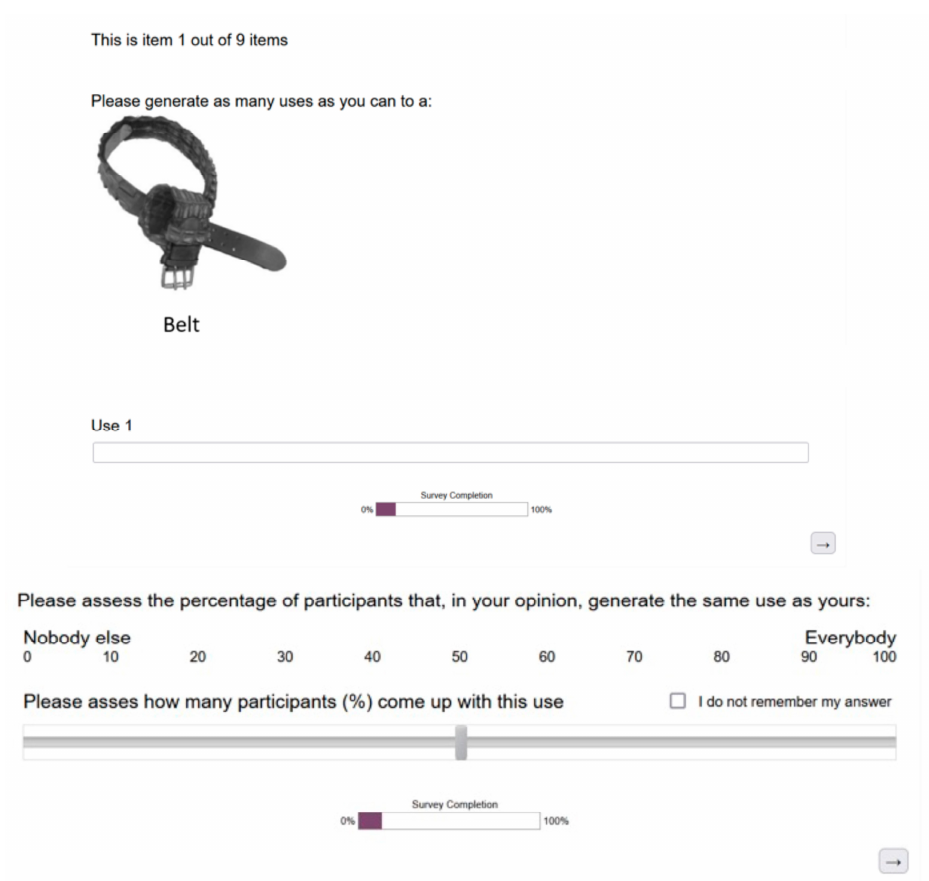
Figure 1 . An example of a trial in the AUT used in Experiment 2. Figure 1. An example of a trial in the AUT used in Experiment